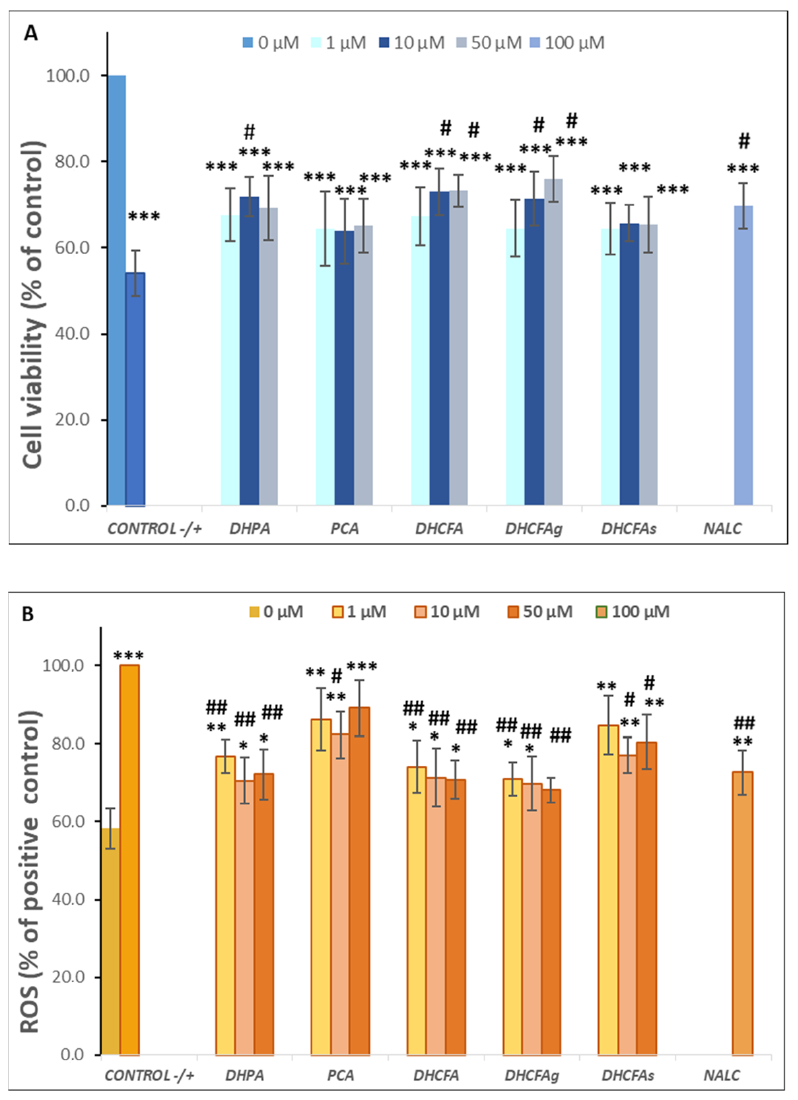
Figure 5. Neuroprotective effects of microbial-derived phenolic acids (DHPA, PCA, and DHCFA) and conjugated derivatives (DHCFAg and DHCFAs) (1, 10, and 50 µ M) on SH-SY5Y cells under t BHP (40 µ M)-induced cell oxidation damage for 24 h of co-incubation. Results of cell viability (% of the control) ( A ) and ROS generation (% of the positive control) ( B ) in t BHP-stimulated cells. *, **, *** Significant differences ( p < 0.05, p < 0.01, p < 0.001, respectively) with respect to the control ( − ); # , ## Significant differences ( p < 0.05, p < 0.01, respectively) relative to the positive control (+).